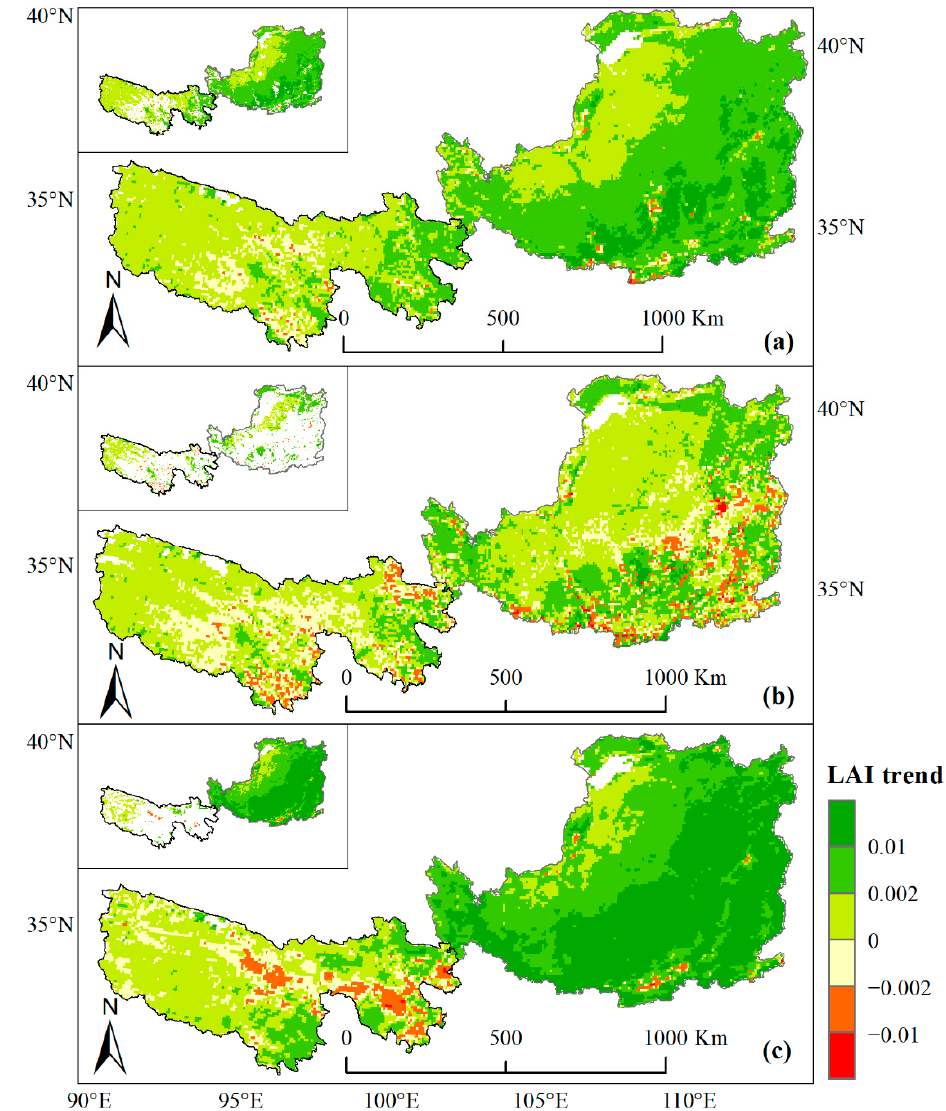
Figure 3. Spatial distributions of the LAI trends over the study areas during the three periods: 1982–2019 ( a ), before the implementation of the ecological engineering project ( b ), and after the implementation of the ecological engineering project ( c ). The inset panels show the pixels where LAI trends are statistically significant at p < 0.05.